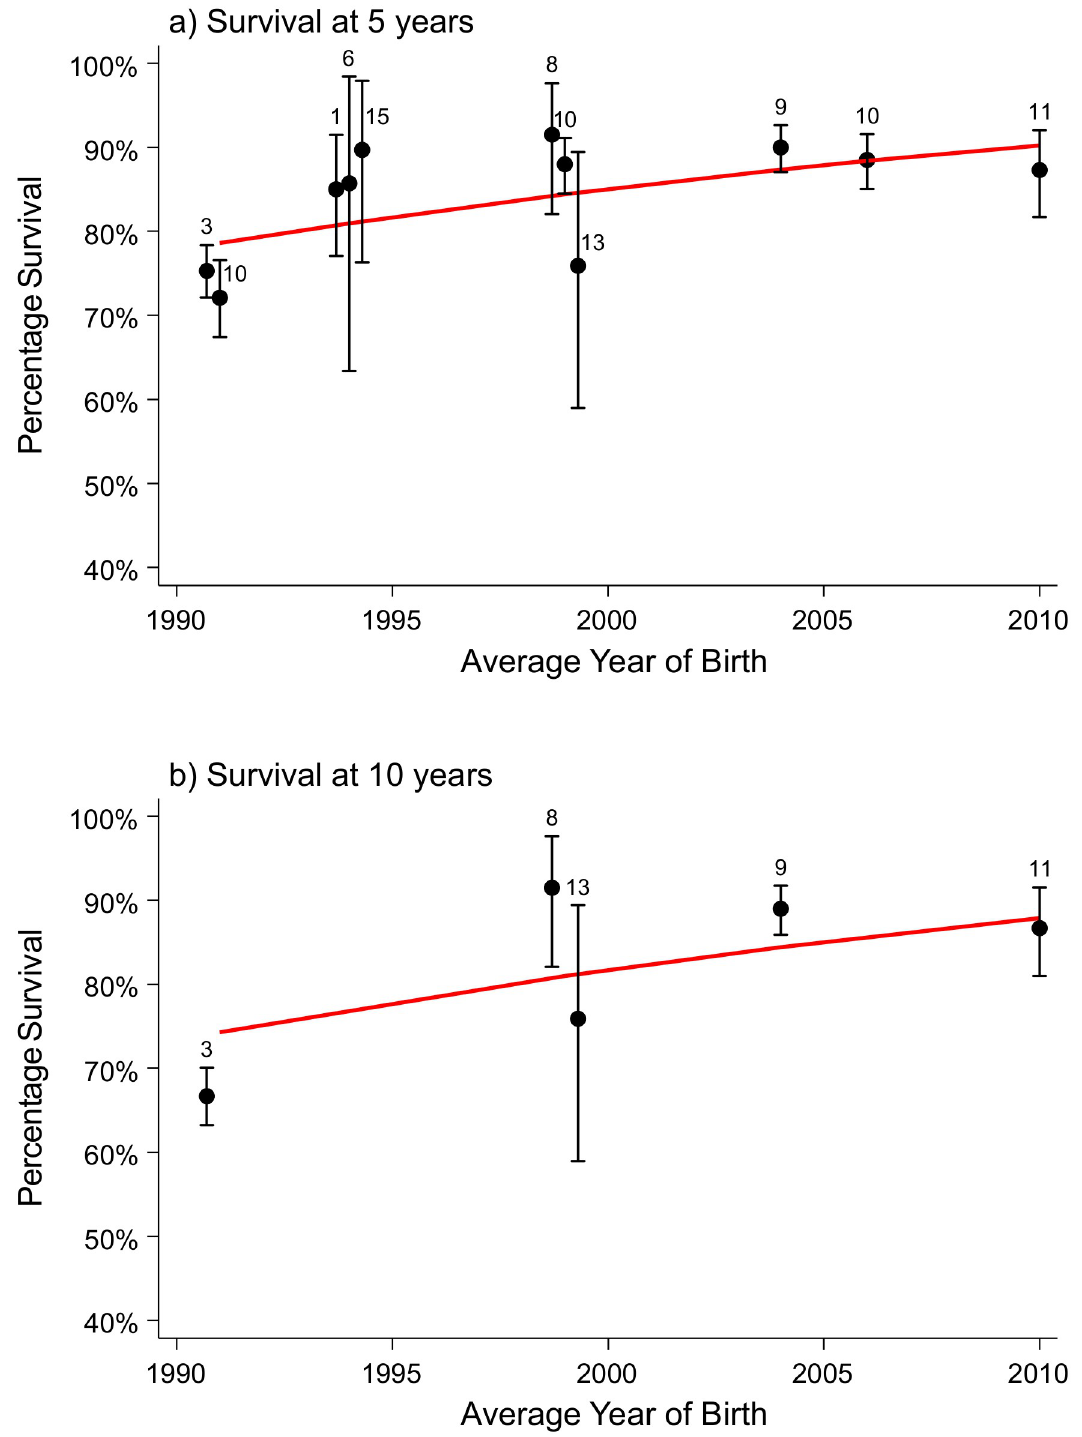
Fig 4. Survival estimates (with 95% confidence intervals) of children with biliary atresia at 5 (a) and 10 (b) years of age over time (11 birth cohorts from 9 studies). The numbers at survival points indicate the included study which may appear more than once if survival was reported for more than one birth cohort: 1 –McKiernan, 2000, UK and Ireland; 3 –Nio, 2003, Japan; 6 –Tennant, 2010, Northern England; 8 –Wildhaber, 2008, Switzerland; 9 –Davenport, 2011, England and Wales, 10 –Chardot, 2013, France; 11 –Pakarinen, 2018, Nordic countries; 13 –Grizelj, 2010, Croatia; 15 –Tu, 2015, South Australia.